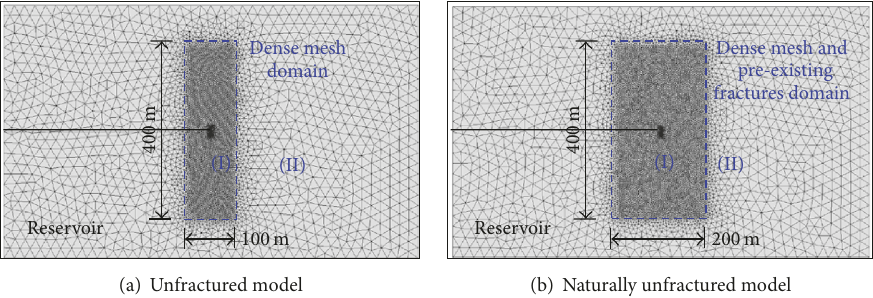
Figure 4: FE models and initial meshes (increasingly denser FE meshes for domains II and